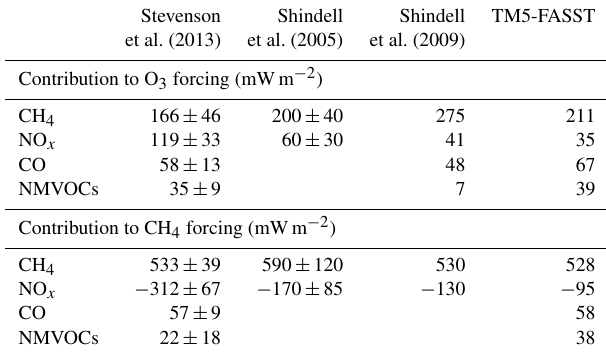
Table 10. Contributions of emissions of CH 4 , NO x , CO, and NMVOCs to O 3 and CH 4 radiative forcing. Stevenson et al. (2013) is for the period 1850–2000, and Shindell et al. (2005, 2009) for the period 1750–2000. FASST shows emission changes from Stevenson et al. (2013) multiplied with FASST global forcing